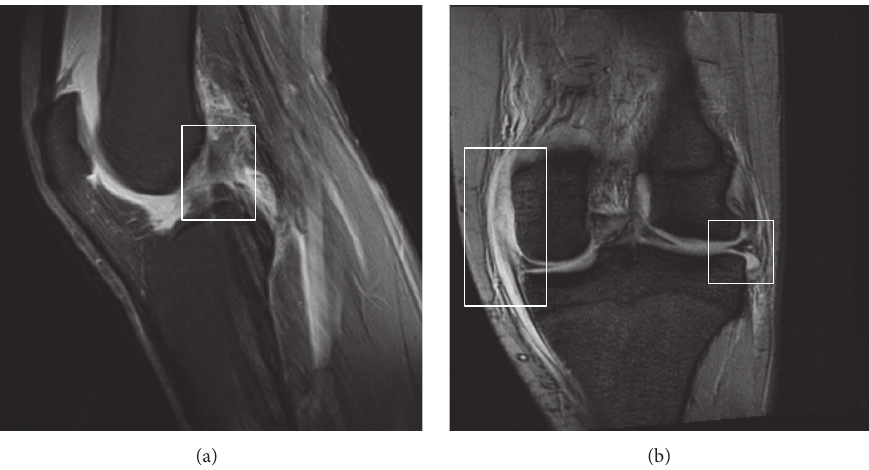
Figure 3: (a) MRI showing a torn anterior cruciate ligament. (b) MRI showing medial collateral ligament injury and displacement of the lateral meniscus.